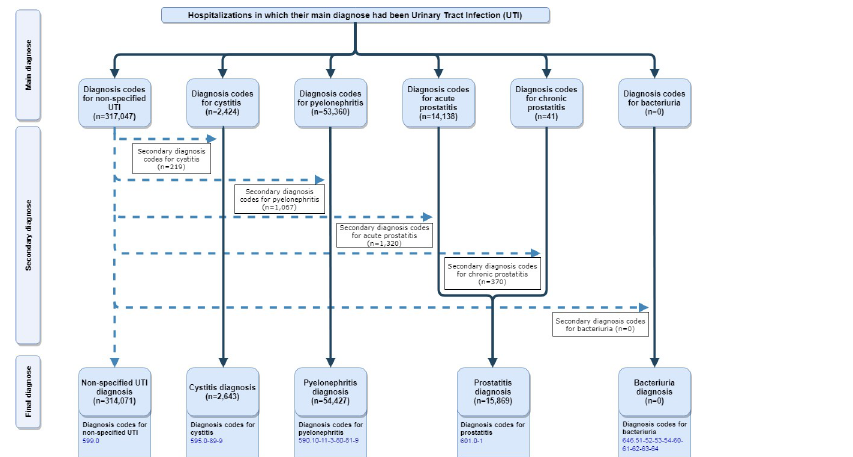
Fig 1. Flow chart. Flow diagram for